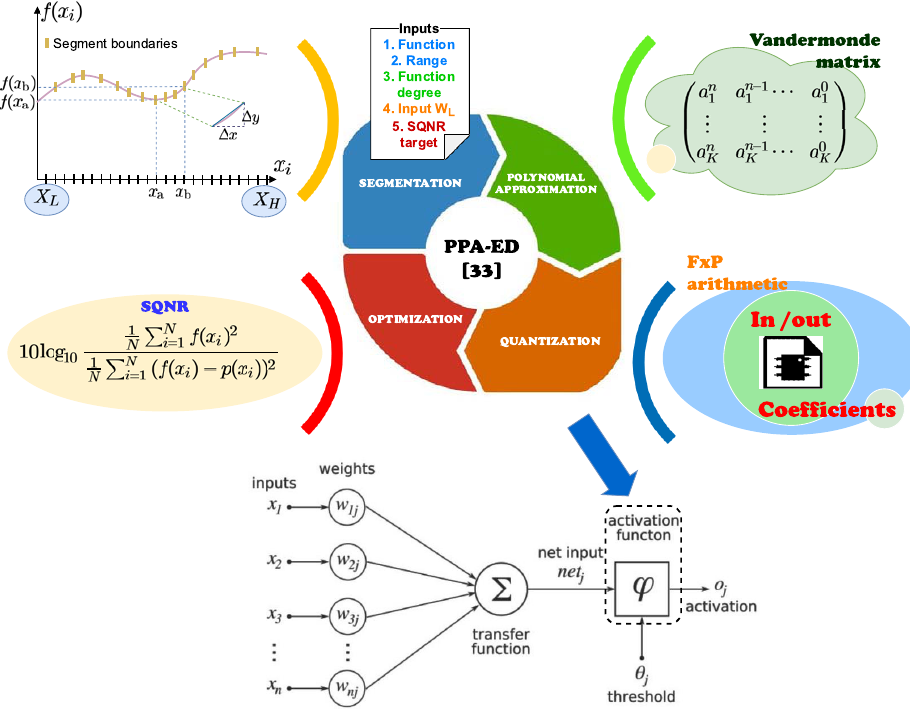
Figure 1. Methodology for designing the